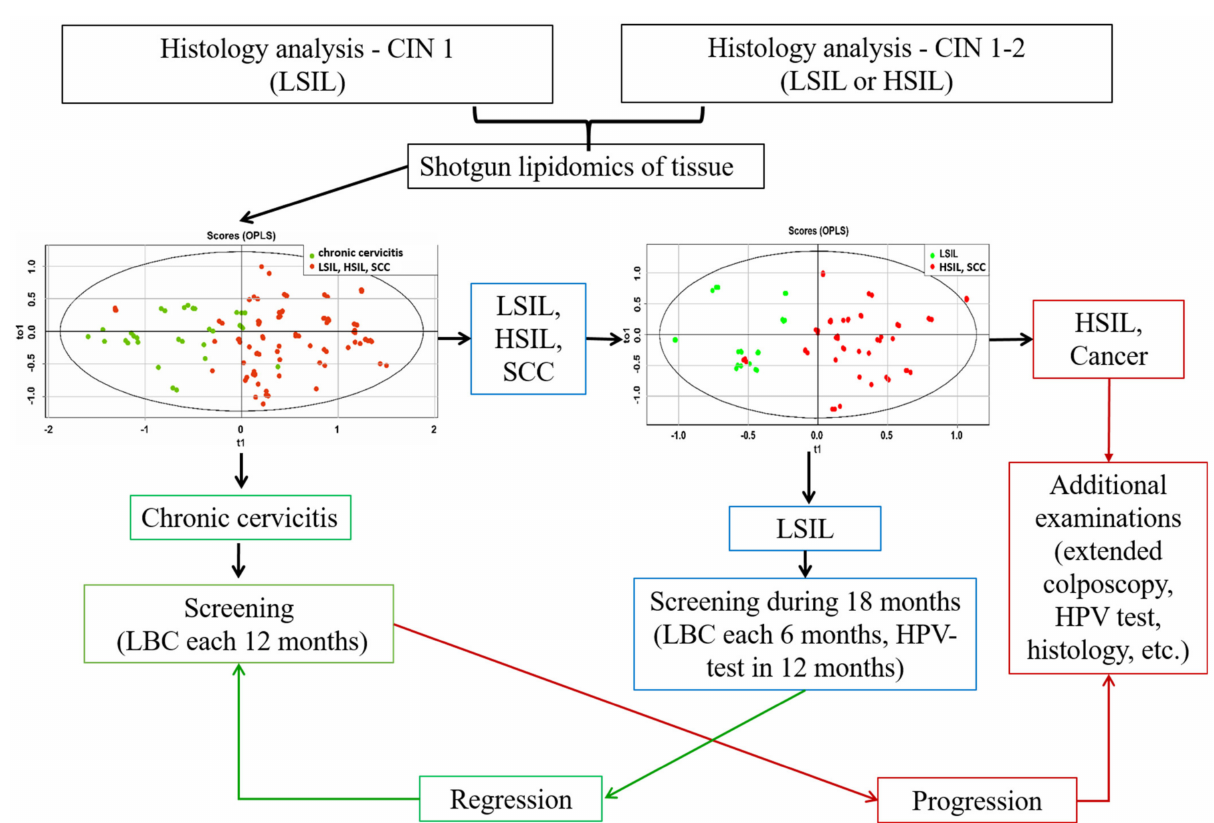
Figure 5. Algorithm for management of patients with HPV-associated cervix transformation including the OPLS-DA models, based on ESI-MS data of cervical tissue